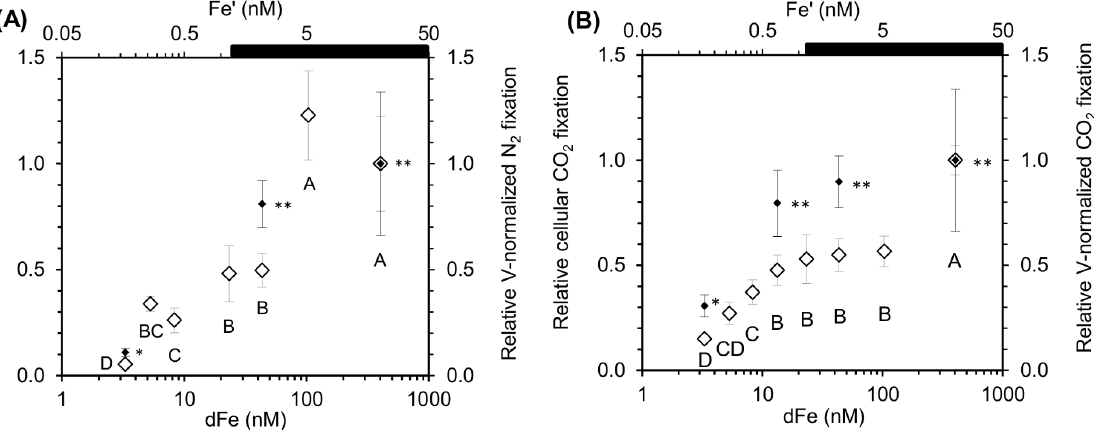
Figure 5. Influence of Fe availability on N 2 and CO 2 fixation rates of C.watsonii . (A) Relative N 2 fixation rates and (B) relative CO 2 fixation rates of C. watsonii related to dFe and Fe 9 concentrations, in log scale. Open and filled symbols correspond to the rates per cell and V-normalized rates respectively. Error bars represent standard deviation; different letters and different numbers of star correspond to statistically different means ( p , 0.05) for cellular and V-normalized rates, respectively. The black bar indicates the region of expected Fe hydroxide precipitation.